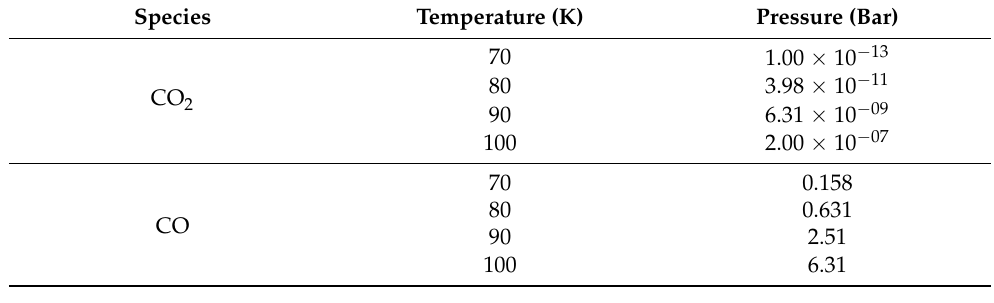
Table 1. Sublimation pressures and temperatures of CO 2 and CO ices. Values from [38] and references therein.